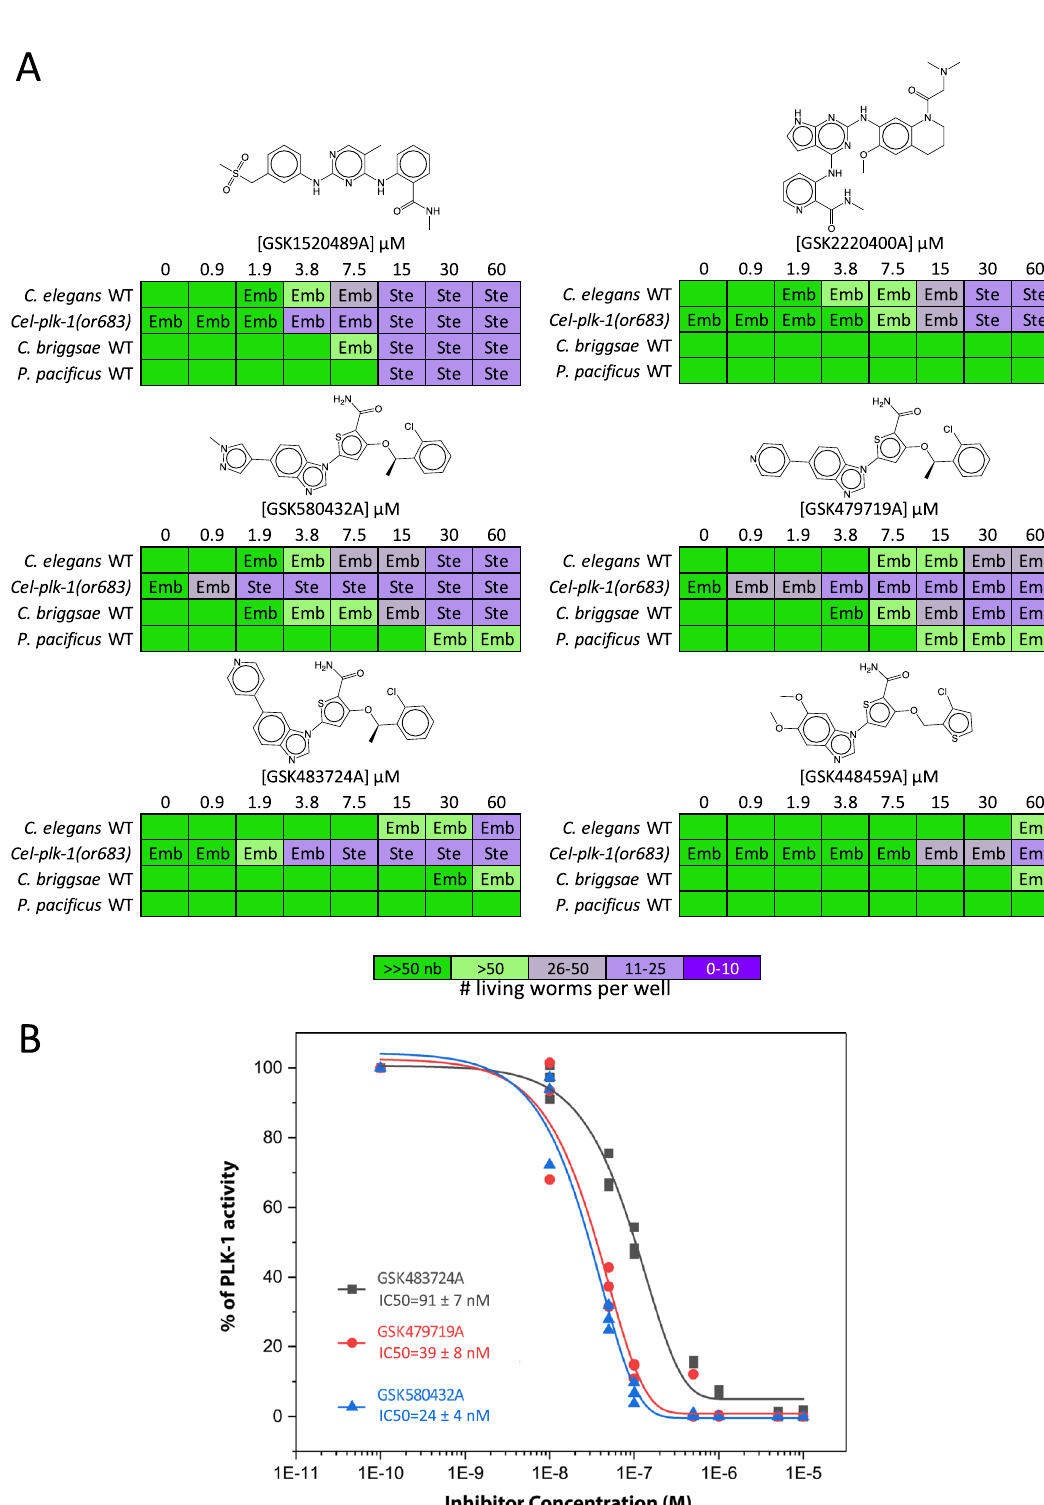
Figure 9. PLK1 inhibitors induce embryonic lethality and sterility phenotypes in nematodes. ( A ) PLK1 inhibitors from three core scaffolds including the 2,4-Dianilinopyrimidines (GSK1520489A), the 2,4-Dianilino pyrrolopyrimidines (GSK2220400A) and Benzimidazole N-thiophenes (GSK580432A, GSK479719A, GSK483724A, and GSK448459A) induce phenotypes consistent with loss of C. elegans PLK-1 including sterility (Ste) and embryonic lethality (Emb) resulting in the population growth defects indicated by the colour coded scale (nb, no bacteria remaining in the well). ( B ) The three Benzimidazole N-thiophene PLK1 inhibitors tested (GSK483724A, GSK479719A and GSK580432A) inhibit C. elegans PLK-1 kinase activity in vitro with IC50 values of 91 nM, 39 nM and 24 nM